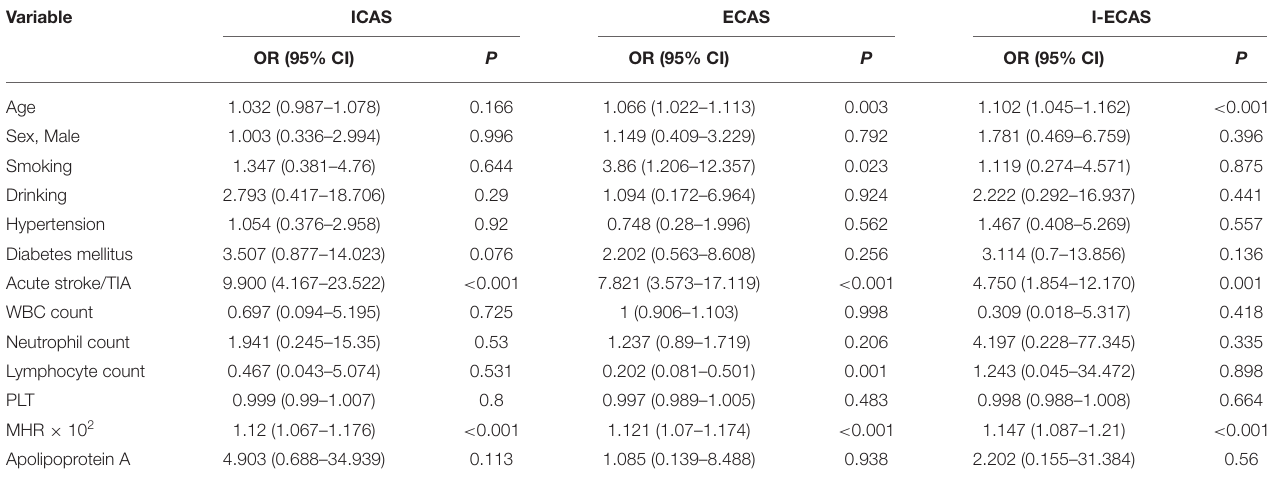
TABLE 4 | The multivariate logistic regression analysis of the distribution of intracranial atherosclerotic stenosis.